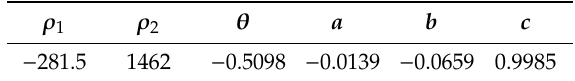
Table 2. Parameters of the temperature-based capacity model.